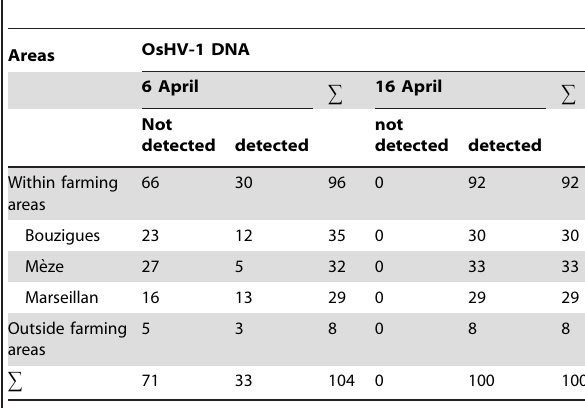
There was no significant effect of sampling areas on the detection of OsHV-1 DNA in oysters ( x 2 test, p = 0.095, Figure S3.1 in File S3). On 16 April, when the mass mortality event started (Figure 2B), OsHV-1 DNA was detected in all experimental units (Table 1). Therefore, the mass mortality of oysters coincided with the general spread of OsHV-1 in oysters of the Thau lagoon. Table 1. Detection of OsHV-1 DNA according to areas and time in oysters deployed in the Thau